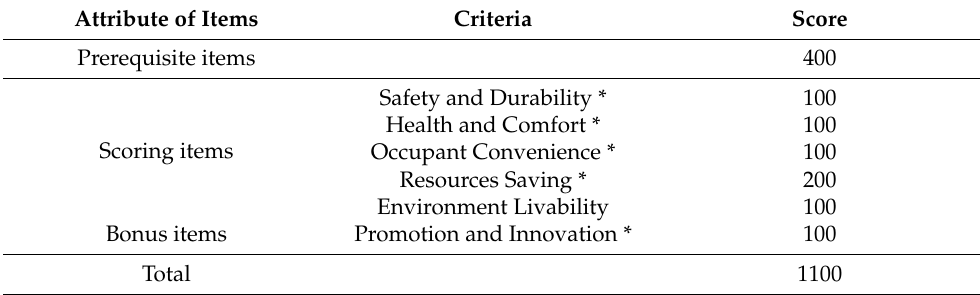
Table 3. Criteria of